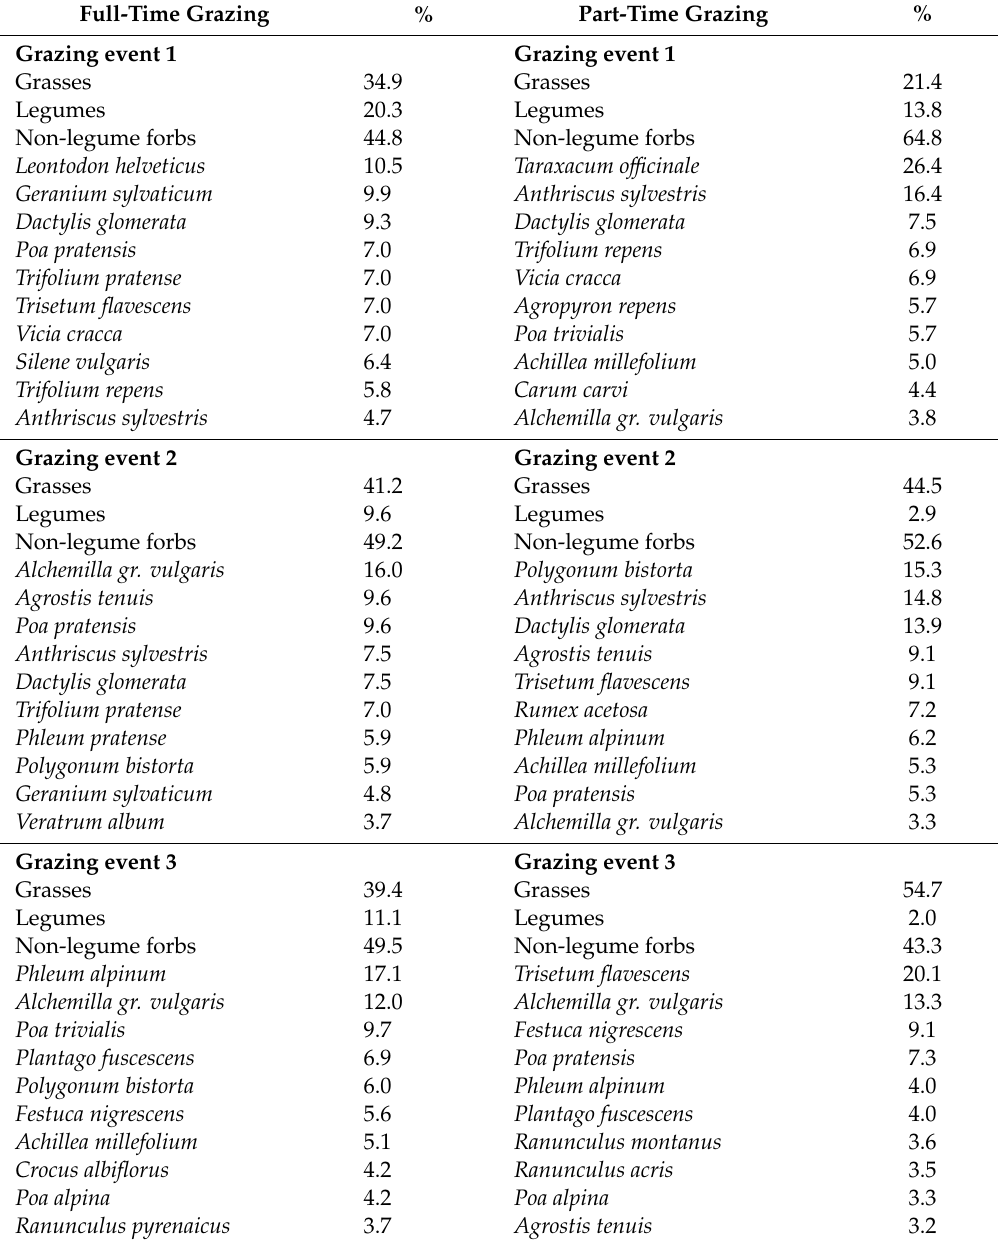
Table 2. Botanical composition of the swards in the two pasture management systems (specific contributions 1 ) in each of the three GEs